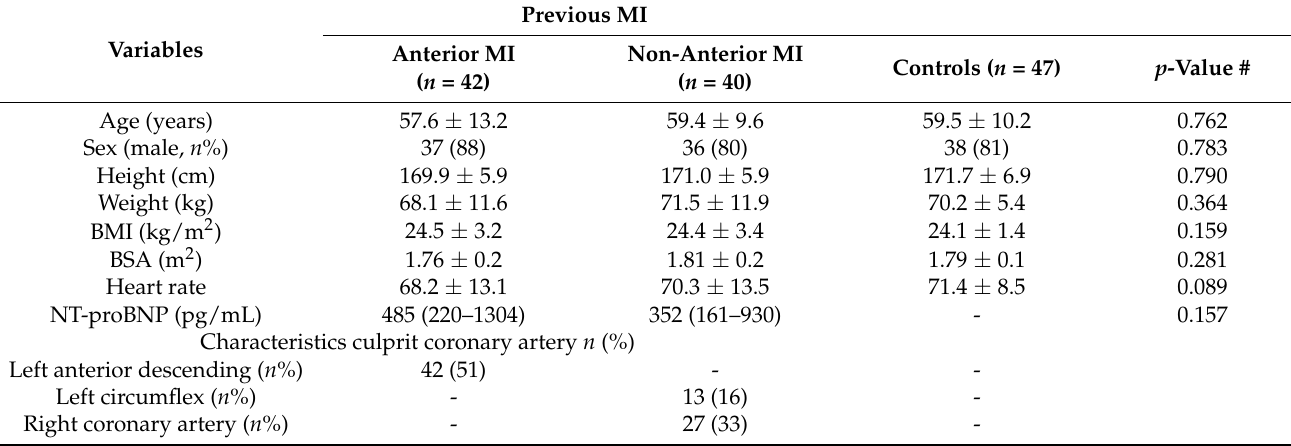
Table 1. Baseline characteristics.